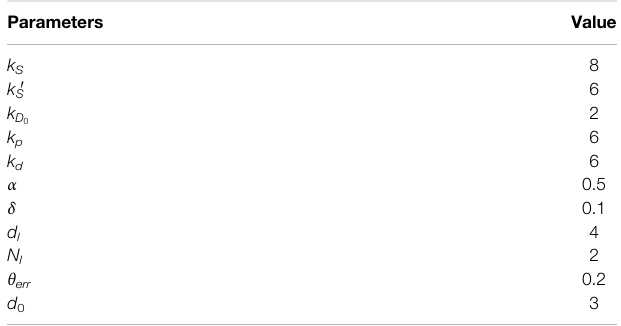
TABLE 2 | Parameters settings for the simulation experiments.